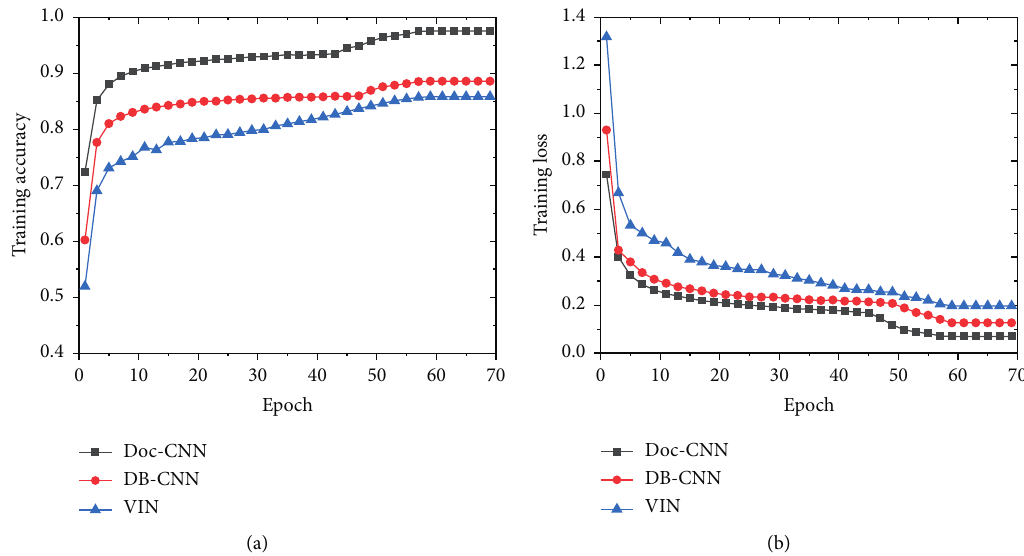
Figure 8: Training performance of all architectures on the ocean map dataset. (a) Training accuracy of the ocean map dataset (b) Training loss on the ocean map dataset. Table 2: Accuracy and success rate of all architectures on two datasets.